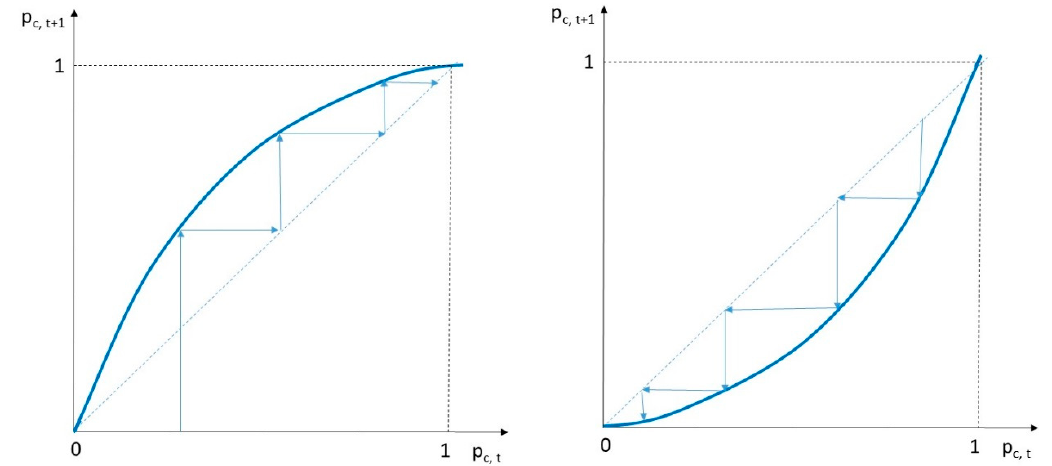
Figure 1. Tax compliance dynamics. Diagram on the left : full tax payment; diagram on the right : no tax payment.